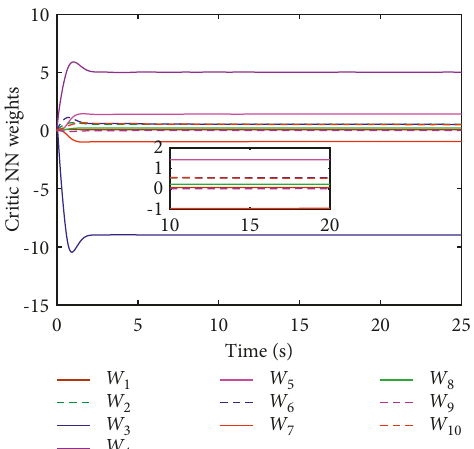
Figure 1: Profiles of CNN weights with